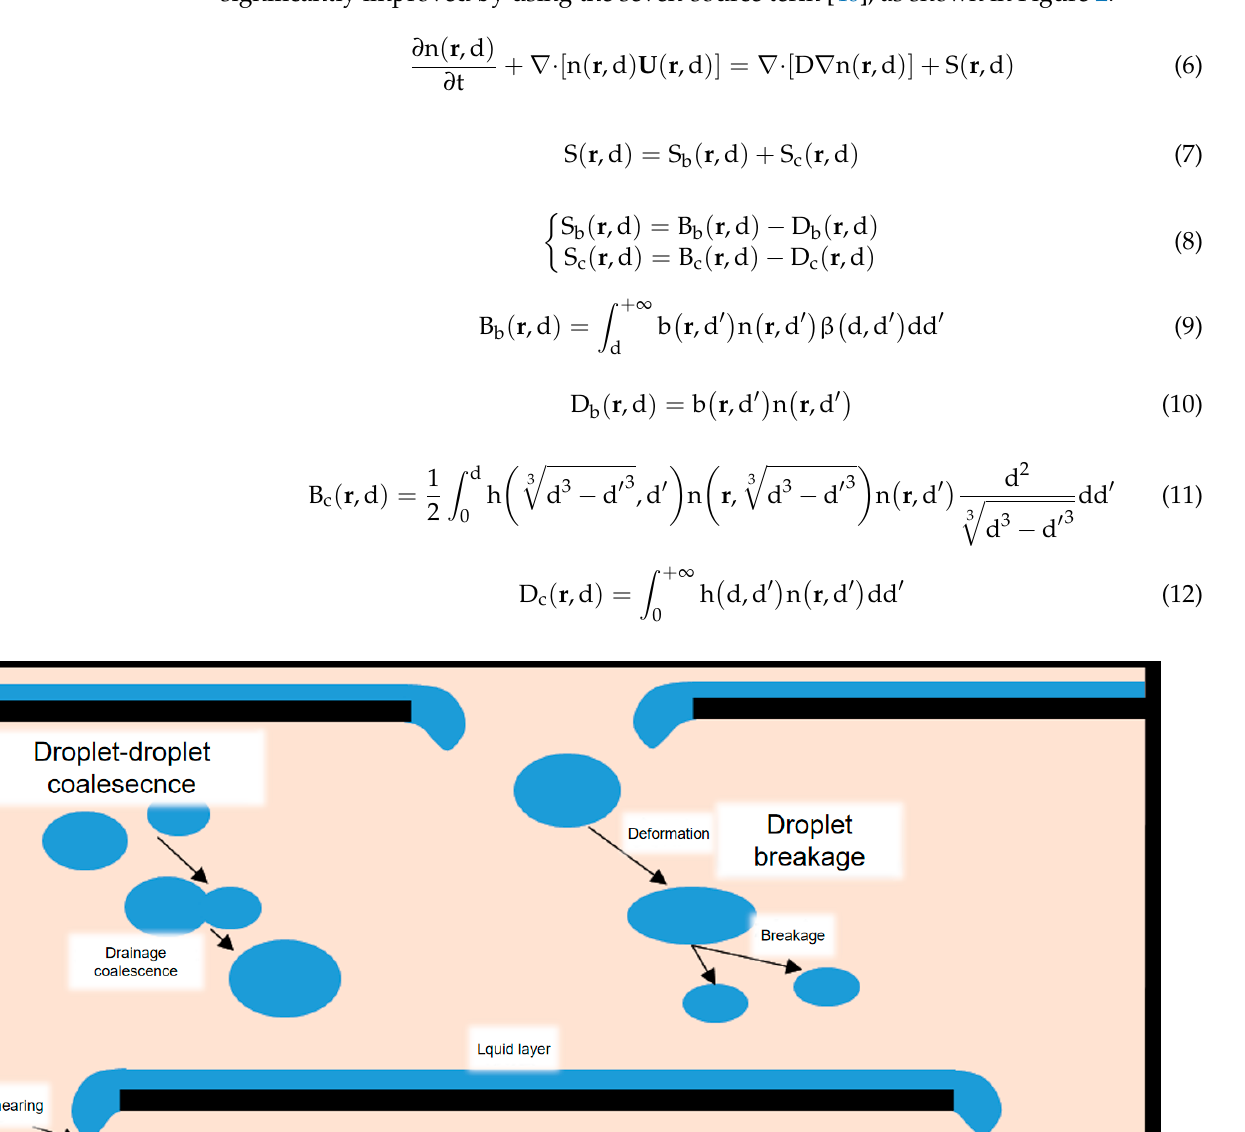
Figure 2. Comparison of droplet size distributions between augmented PBM and original PBM. Re- printed with permission from Ref. [46]. 2020, ACS (American Chemical Society). By coupling CFD with PBM, researchers studied the two-phase flow of a variety of extractors. Some of these studies are summarized in Table 3. Drumm et al. [47] carried out CFD-PBM simulation in the rotating disc column, and the hold-up and velocity field were in good agreement with the experimental values. Mirzaie et al. [48] carried out CFD-PBM simulation in the pulsed packing column, and the results were good for predicting the hydrodynamic characteristics of the column. Amokrane et al. [49] used the CFD-PBM